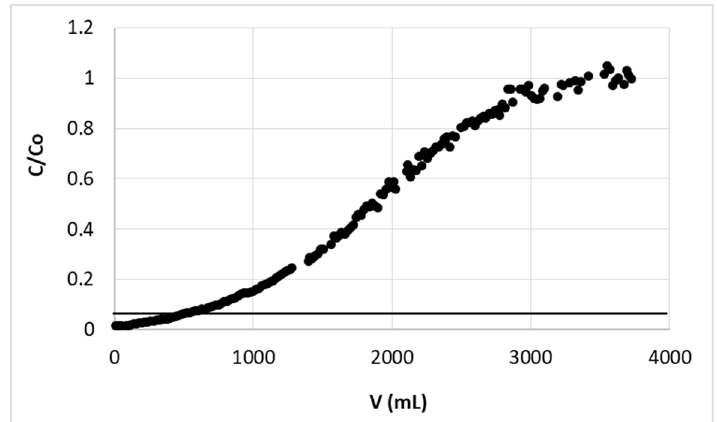
Figure 1. Zinc(II) ions breakthrough curve on hybrid pectin-based biosorbent. Mass of sorbent (dry form, fine grain): 1 g; flow rate: 30 mL/h; initial concentration of Zn: 30 mg/L; pH = 6.